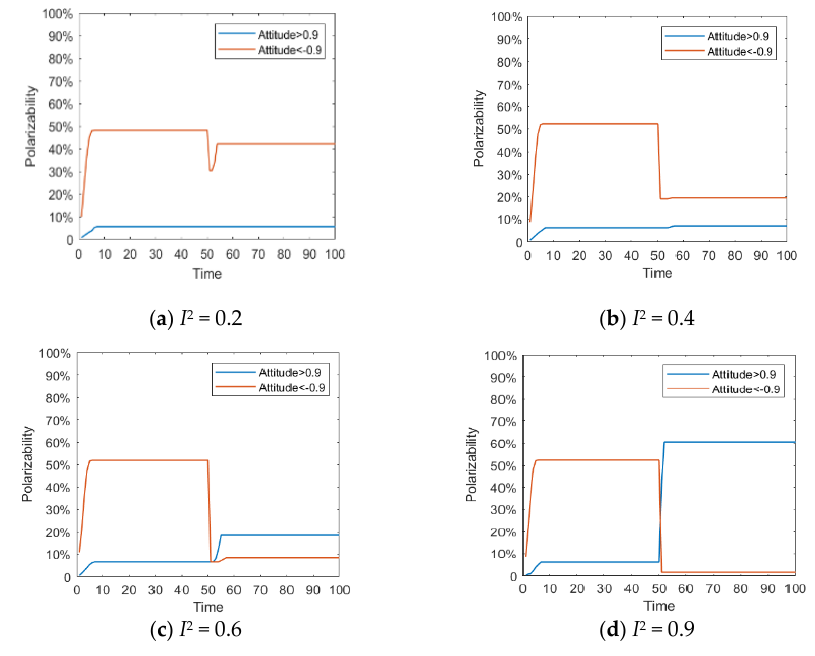
Figure 7. Polarization curve. ( a ) I 2 = 0.2; ( b ) I 2 = 0.4; ( c ) I 2 = 0.6; ( d ) I 2 = 0.9.